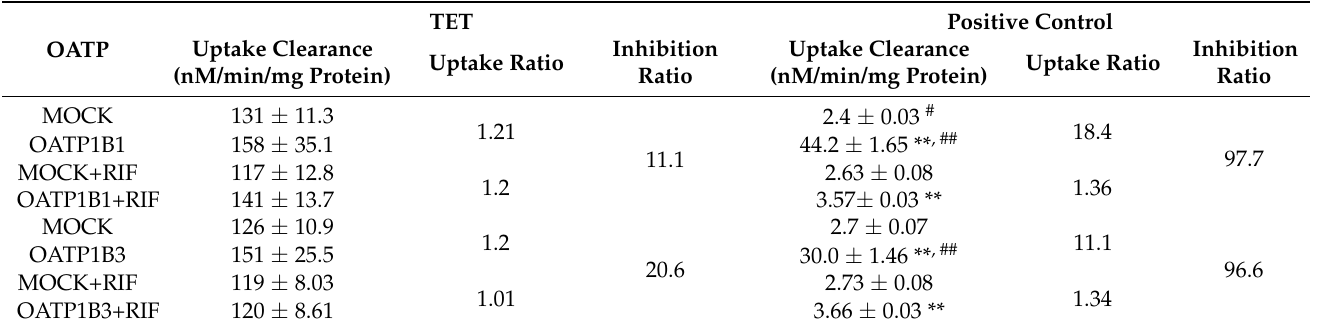
Table 4. The uptake parameters of TET by OATP-transfected and MOCK HEK293 cells ( n = 3, Mean ±